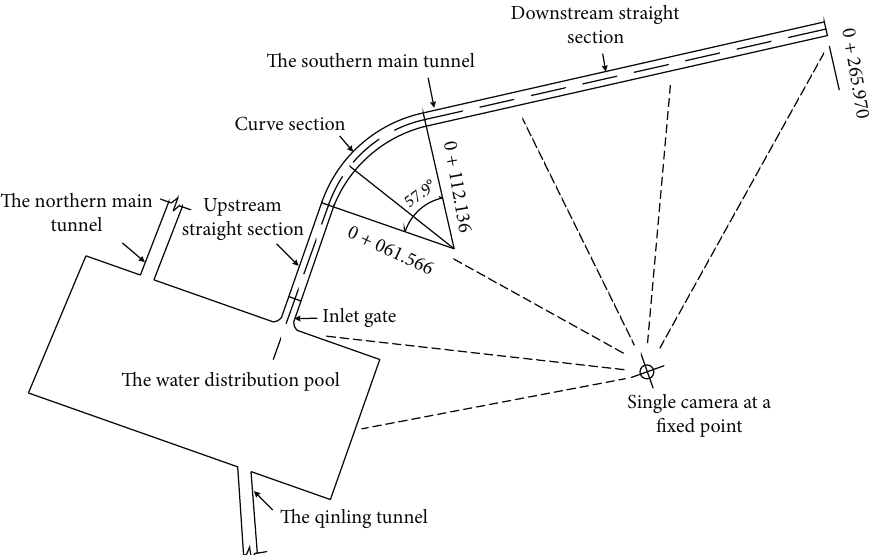
Figure 1: The original scheme for measuring the instantaneous water level by erecting steel rulers with multiple points to be measured with a single